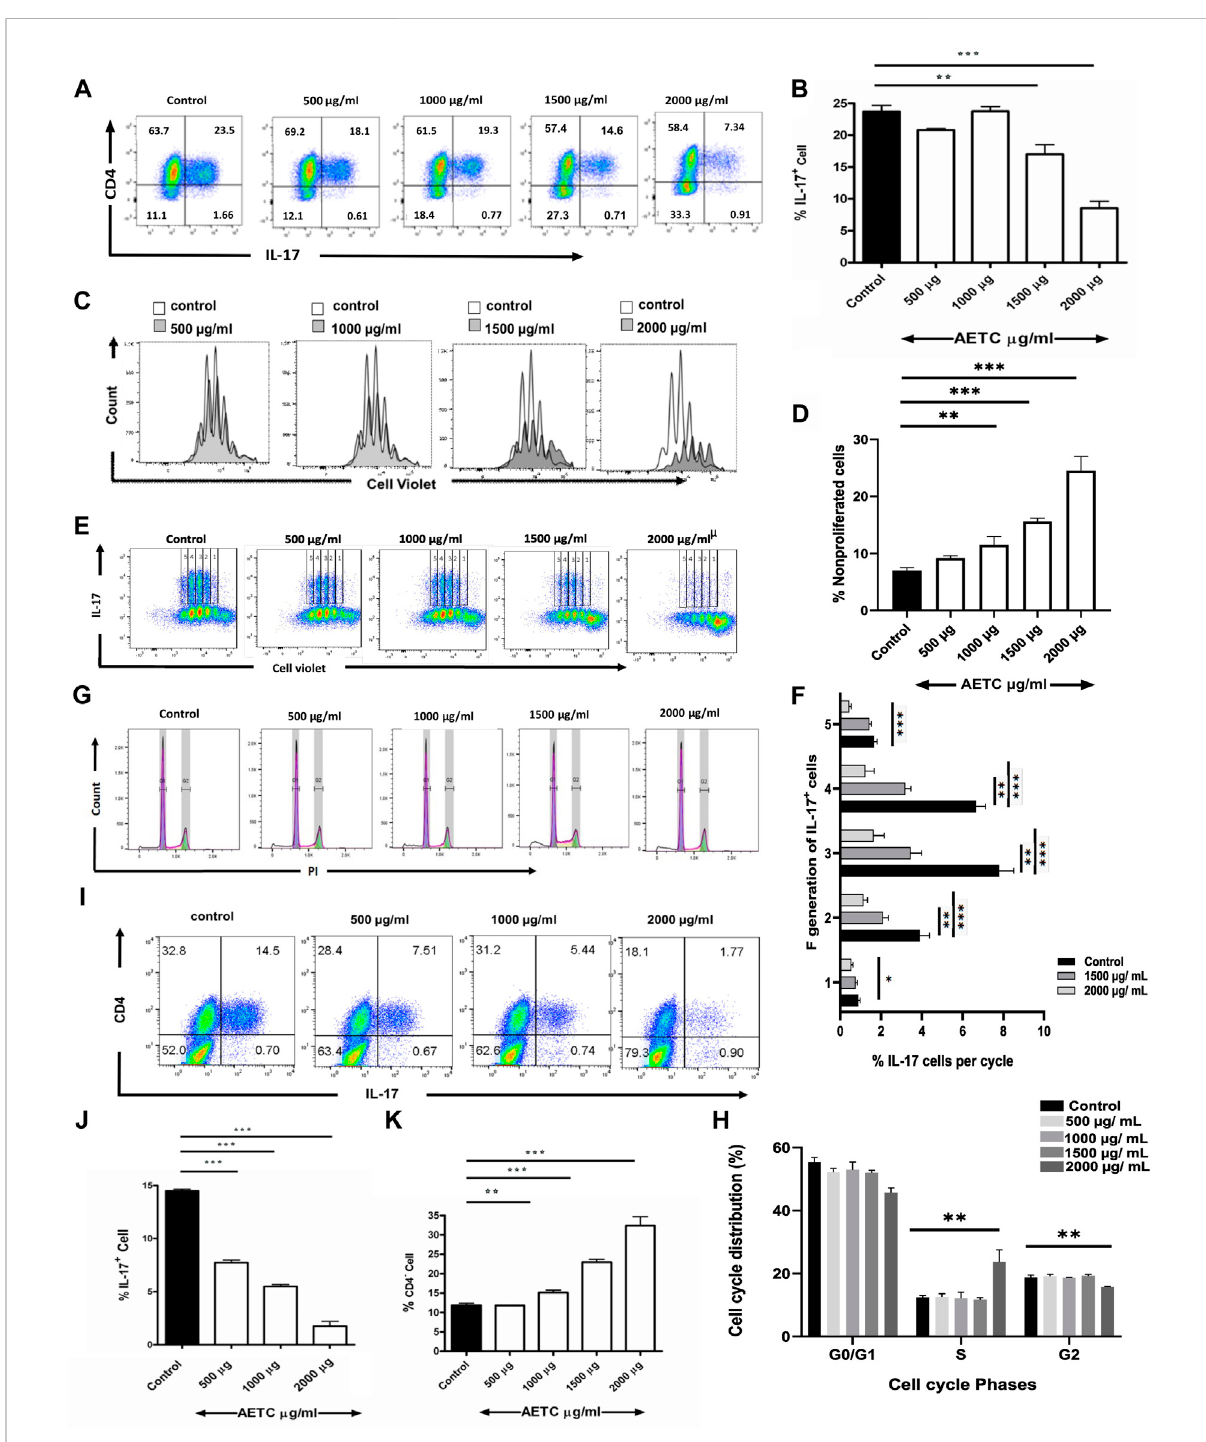
FIGURE 2 T.cordifolia extractreducesTh17cellfrequency,exhibitsanti-proliferativeactivityonCD4 + Tcells,andpromotestheproliferationofCD4 − cells. (A,B) FrequencyofIL-17 + cellsfollowingcultureofnaiveTcellsfor4 daysunderTh17-polarizingconditionsinthepresenceofAETC(500 – 2000 µg/ ml) or vehicle control. Cells were stained for intracellular IL-17 and were gated on live cells. (A) Representative fl ow cytometry. Numbers represent thepercentageofCD4 + and IL-17 + Tcells among totallive cells. (B) Percentage ofIL-17 + cellsamongtotal live CD4 + Tcells cultured with AETC (500 – 2000 µg/ml) or vehicle control. (C,D) The proliferation of AETC (500 – 2000 µg/ml) or vehicle control as assessed by the cell proliferation dye CellTrace violet. Cells were stained for intracellular IL-17 and gated on live CD4 + T cells. (C) The histogram represents an overlay of cell count for vehiclecontrol versus AETCtreatedgroups. (D) Bargraphsrepresentthepercentageofnonproliferatedcells. (E,F) , (E) Representative fl